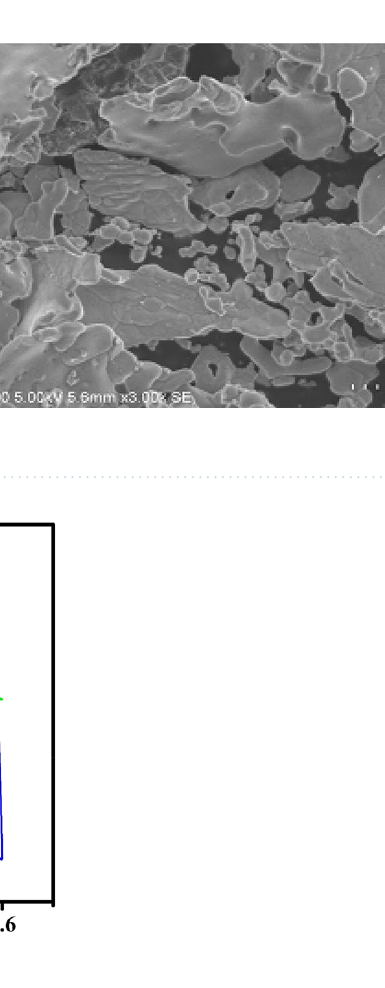
Figure 5. CVs for PA (0.1 mM) in 0.2 M PBS (pH 7.4) at bare CPE (A) and PoOCD/MCPE (B) at SR 100 mVs −1